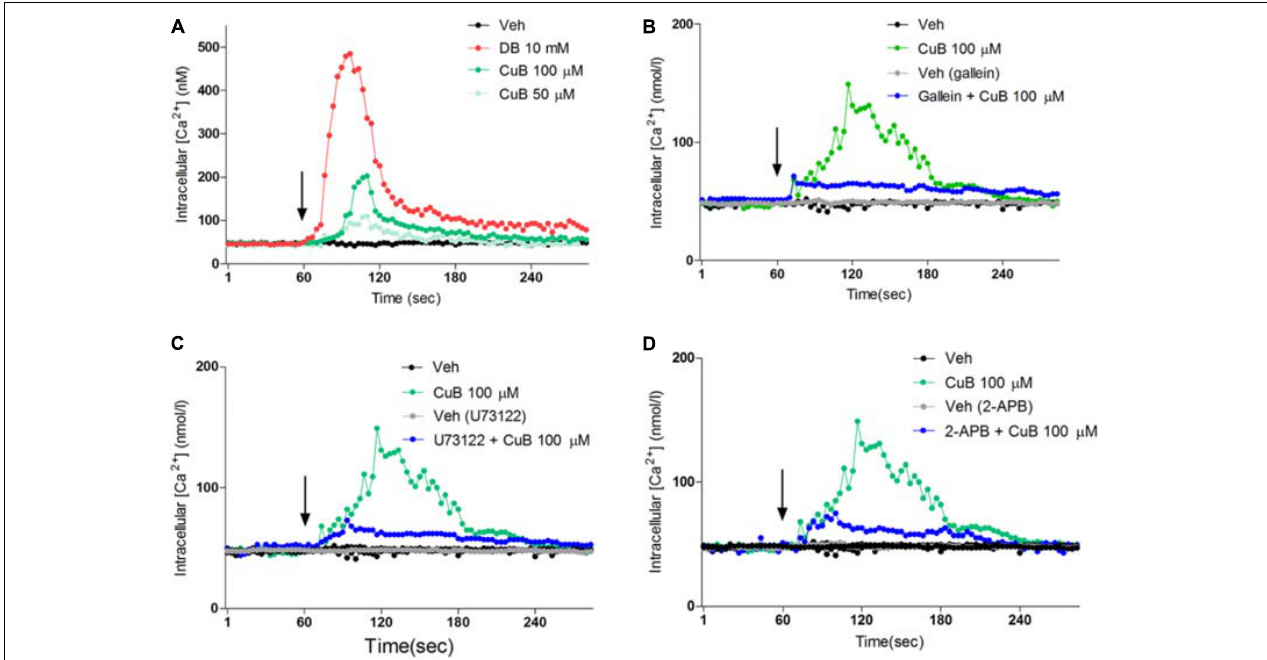
FIGURE 5 | Cucurbitacin B stimulates intracellular calcium through G βγ -signaling pathway. (A) The [Ca 2 + ] i increase in response to CuB 100 µ M (Green) or, 50 µ M (mint) was exhibited. (B) After treatment of gallein (10 µ M) for 30 min, CuB was treated on each inhibited condition of G βγ (Blue). CuB-mediated intracellular calcium efflux was inhibited by gallein. (C) After treatment of 2-APB (10 µ M) for 30 min, the CuB-mediated intracellular calcium efflux was inhibited by 2-APB. (D) After treatment of PLC β , U73122 (10 µ M) for 30 min, the CuB-mediated intracellular calcium efflux was inhibited by U73122. Vertical arrow indicates drug